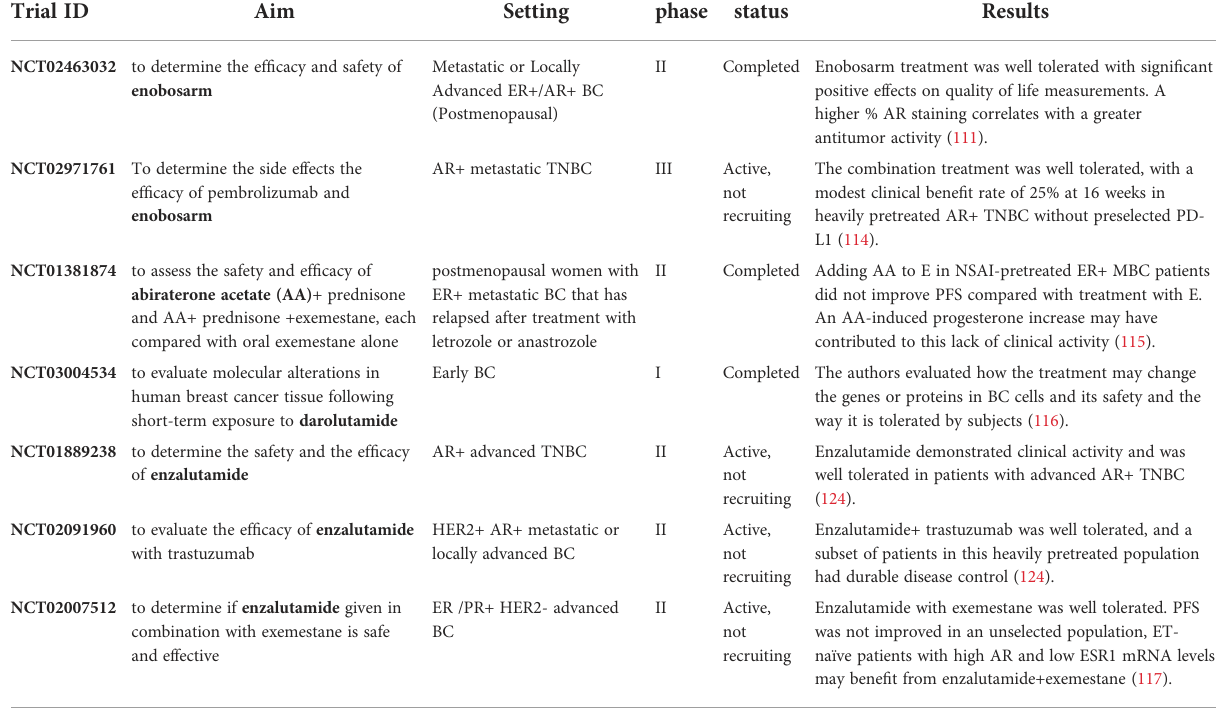
TABLE 2 Ongoing clinical trials including AR agonists and antagonists with